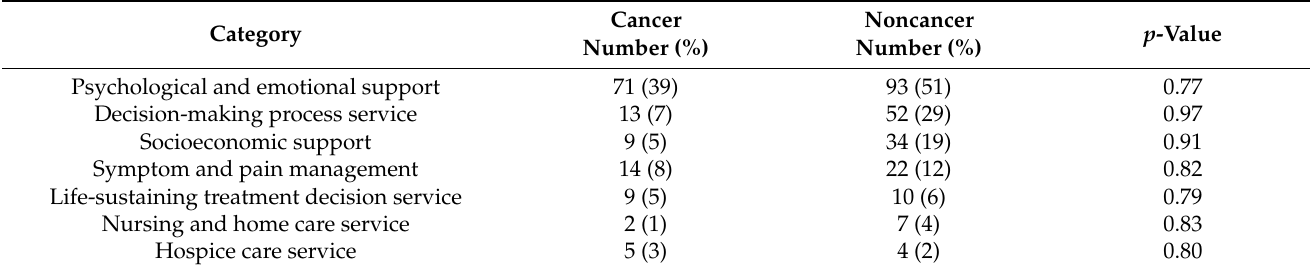
Table 2. Primary reasons for the need for palliative care.